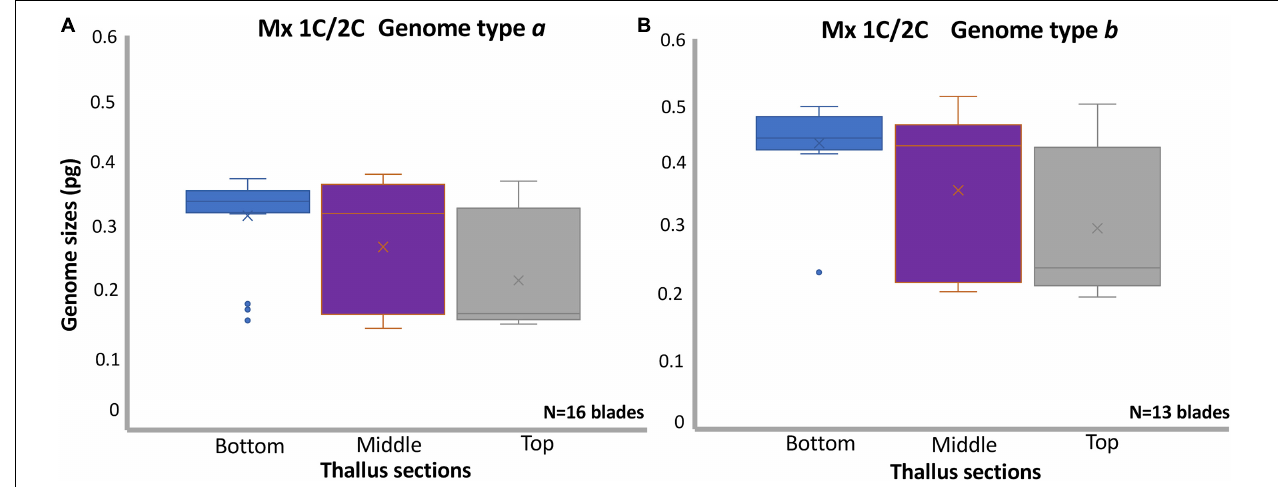
FIGURE 2 | Boxplots displaying the genome size variation in sections of vegetative thalli in Porphyra linearis : (A) Thallus sections (sample size for bottom N = 19, middle N = 26, top N = 23) in 16 mixoploid blades 1C/2C genome type a , (B) Thallus sections (sample size for bottom N = 13, middle N = 17, top N = 18) in 13 mixoploid blades 1C/2C genome type b . The x near the median bar indicates the location of the sample mean. Samples means with standard deviation and medians for each class were for subplot (A) , bottom: 0.33 ± 0.06, 0.34, middle: 0.27 ± 0.09, 0.32, top: 0.22 ± 0,08, 0.17; for (B) , bottom: 0.43 ± 0.06, 0.44, middle: 0.37 ± 0.12, 0.43, top: 0.30 ± 0.11, 0.24. Differences in mean genome sizes are significantly different when comparing genome sizes in the bottom area of each blade vs the middle area ( t -test, P < 0.05) and vs. top area ( t -test, P < 0.001) for both mixoploid blades either a or b . Mx,